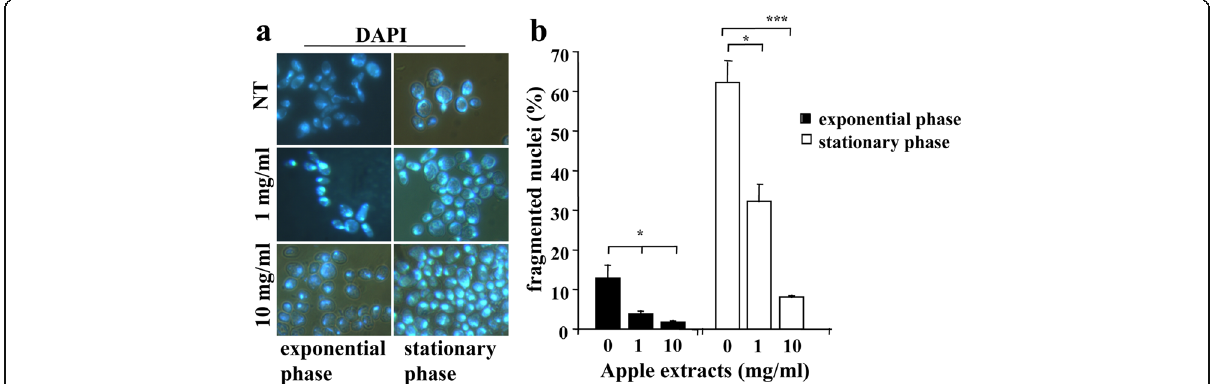
Fig. 4 DAPI staining of the Kllsm4 Δ 1 cells during exponential and stationary phases ( a ) in the absence (NT) and in the presence of apple extracts at the indicated concentrations. ( b ) represents the percentage of fragmented nuclei in three independent experiments. p -value: *<0.05; ***<0.001